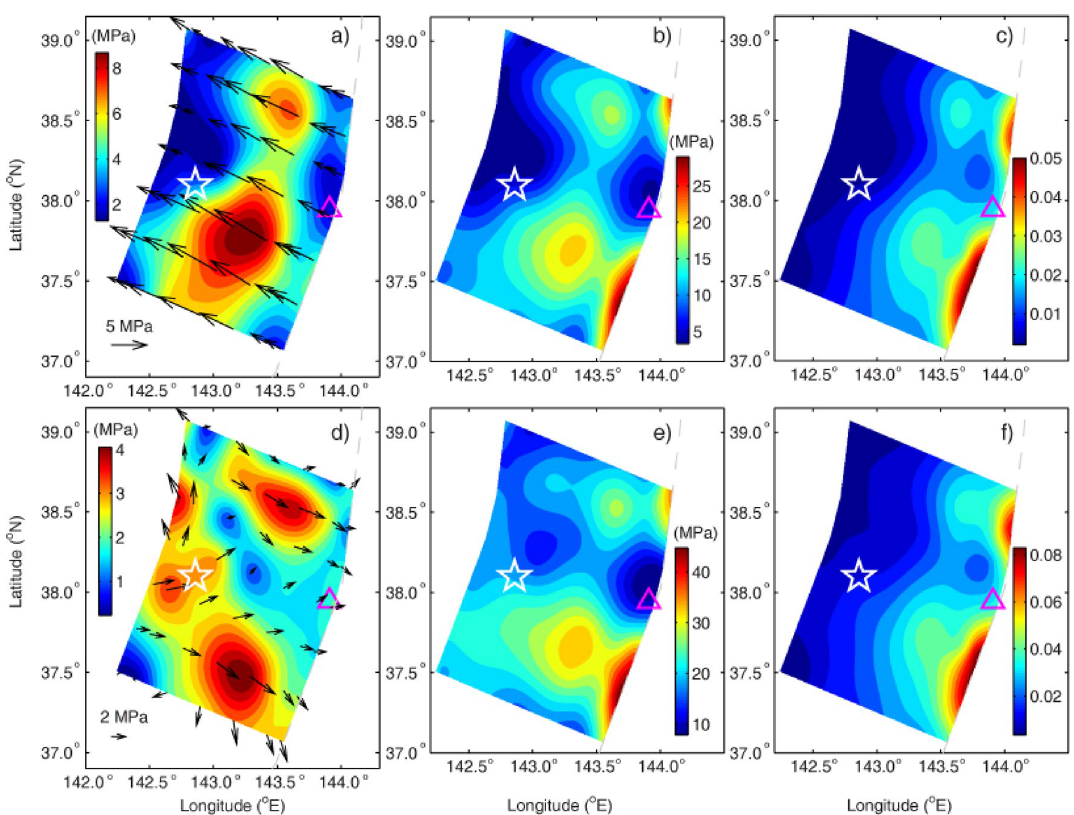
Figure 3. Predicted the shear and normal stresses and effective coefficient from the ME. ( a , b ) Pre-seismic shear and normal effective stresses along the fault, respectively. ( d , e ) Post-seismic shear and normal effective stresses along the fault, respectively. ( c , f ) Effective frictional coefficient of the pre-and post-fault rupture along the fault,